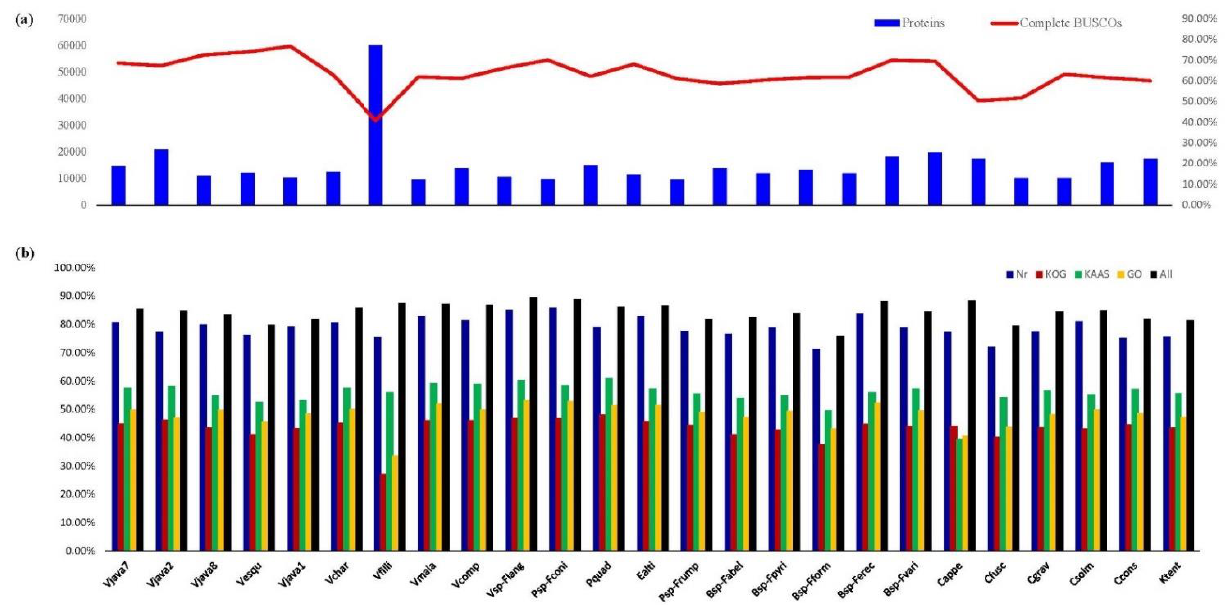
Figure 1. Functional characters of 25 fig wasps~: ( a ) the total number of proteins annotated for 25 fig wasps and the completeness of the transcriptomes identified for them by BUSCO; ( b ) proportions of genes annotated by Nr, COG, KAAS, GO, and all datasets for the 25 fig wasps.